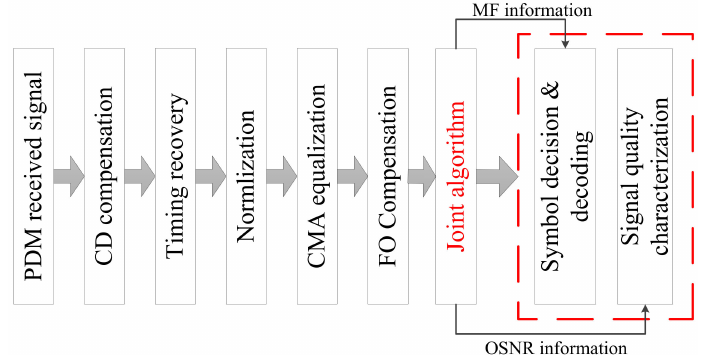
Figure 1. DSP model of MFI and OSNR estimation based on DBSCAN